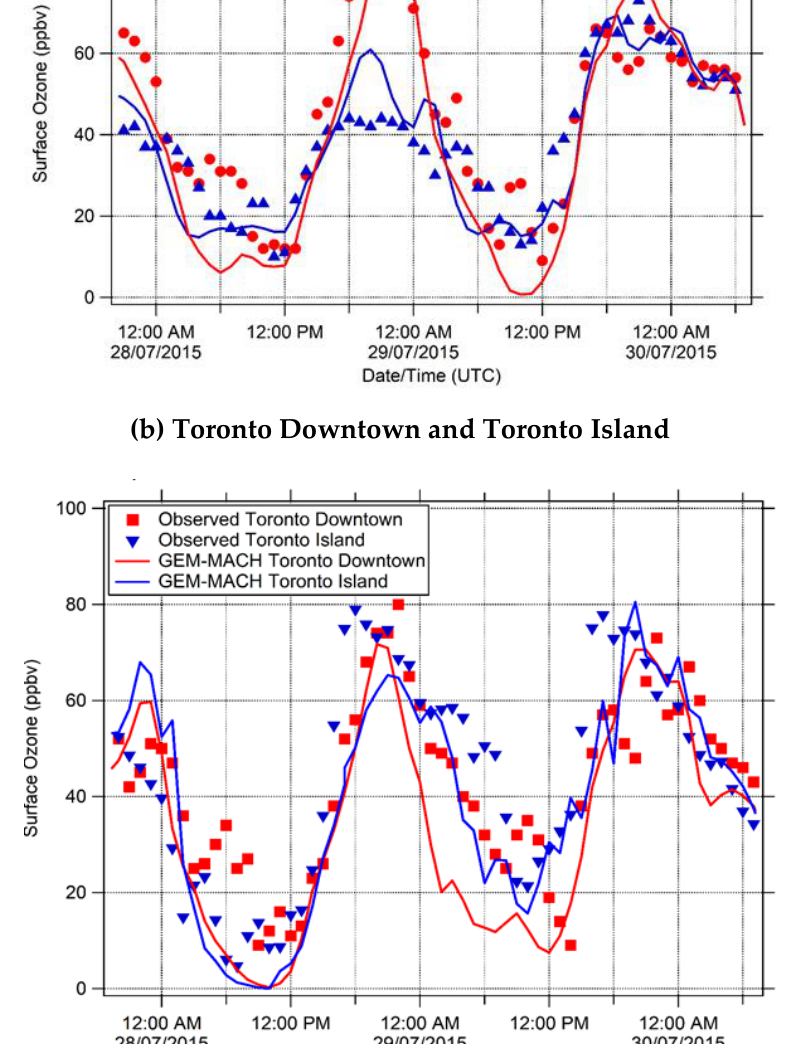
Figure 11. A 48-h observed and GEM-MACH-TEB modeled O 3 time series for North Toronto (red, panel ( a )), Newmarket (blue, panel ( a )), downtown Toronto (red, panel ( b )) and Toronto Island (blue, panel ( b )) sites from 21:00 UTC 27 July 2015 to 06:00 UTC 30 July 2015.